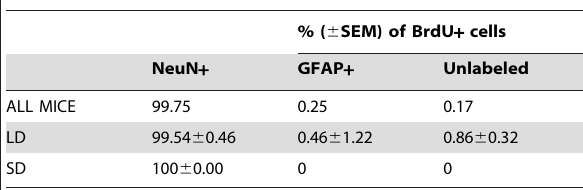
Table 1. Phenotype of progenitor cells 4 weeks after BrdU injections in the granule cell layer of the olfactory bulb of LD and SD exposed male P. leucopus